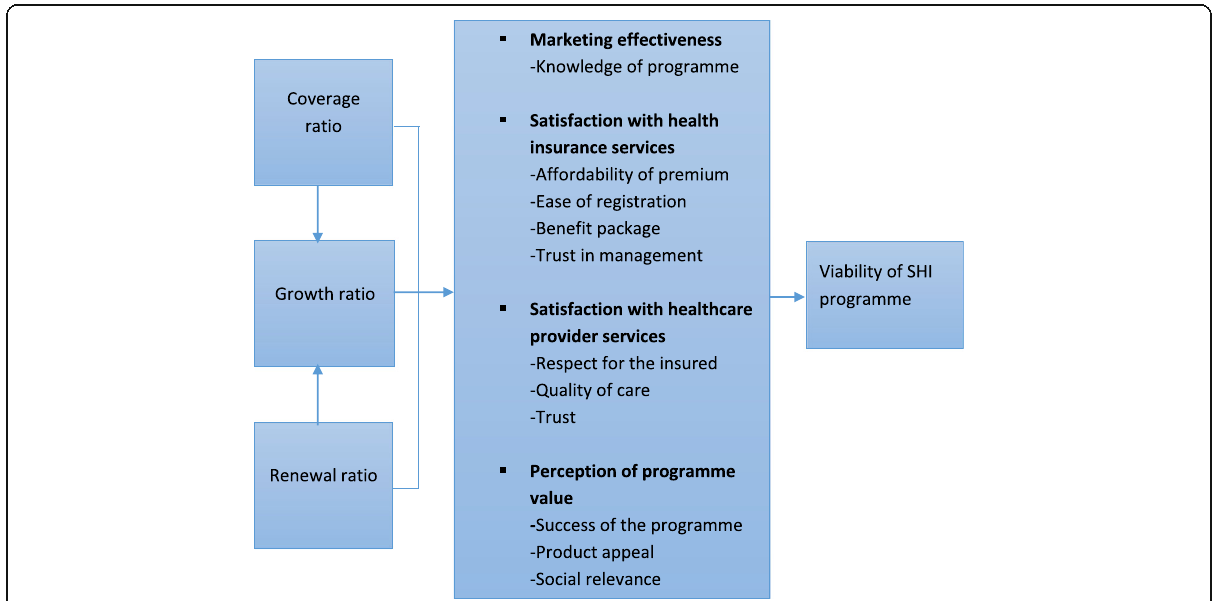
Fig. 1 Conceptual framework for assessing viability of social health insurance programme. Source: Adapted from Wipf & Garand